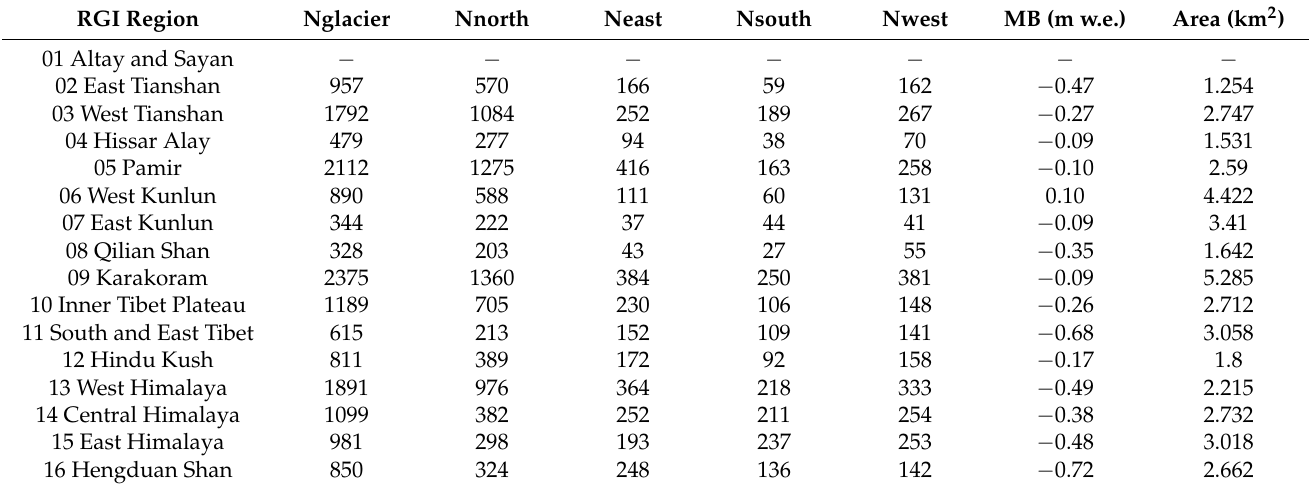
Table 3. Summary of the regional glaciers with mass balances that were significantly correlated with topographic shading during